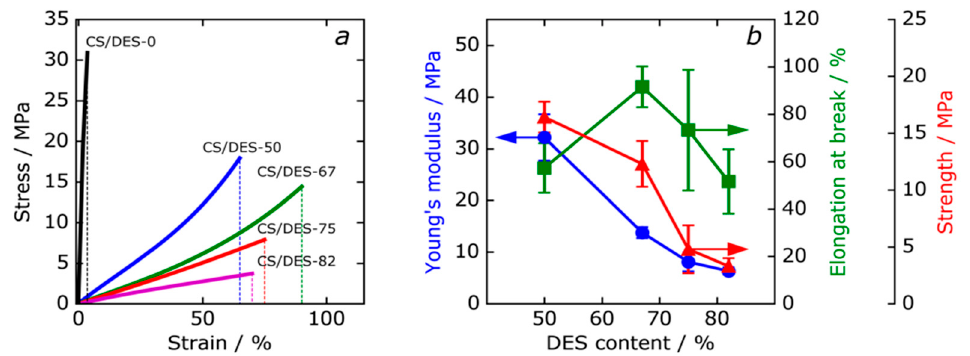
Figure 10. Typical view of stress-strain curves for the reference CS film (CS/DES-0) and composites with different NADES contents ( a ). Dependences of mechanical properties of the films on the NADES content ( b ). Table 4. Mechanical properties of CS film with LA (CS/DES-0) and films with different NADES content.